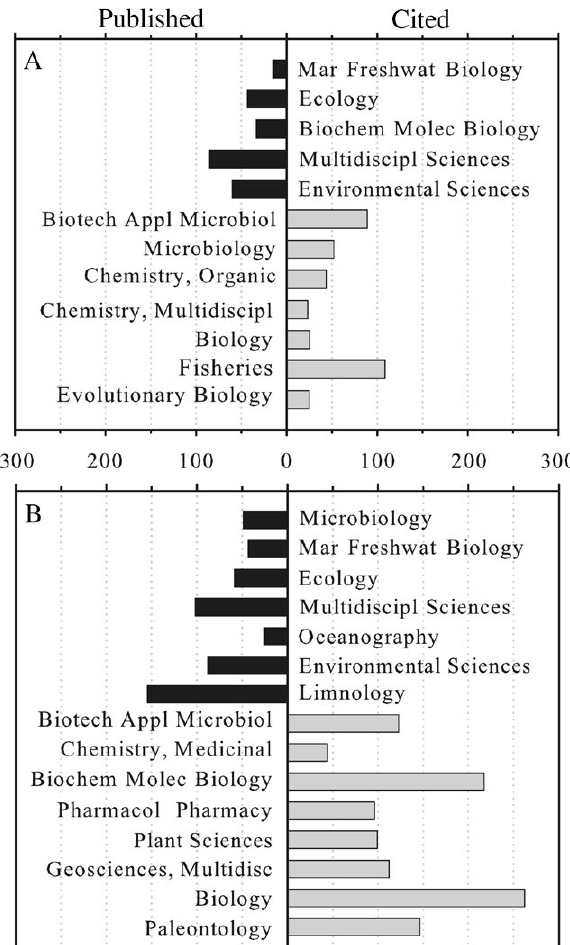
Fig. 2. – Increasing rate (%) of papers on chemical (A) and micro- bial (B) ecology published ([published − cited] / cited; in black) or cited ([cited − published] / published; in grey) within several subject categories found in the Science Citation Index Expanded database. Subject categories were ordered within published or cited papers as a function of the percentage of the total papers represented by each category in descending order. The remaining categories were excluded either because the proportions of papers published or cited were equivalent (i.e. the relative value did not deviate from 1) or because the percentage of the total papers in a subject category was below 1%. Black bars show a higher proportion of chemical and microbial ecology papers published than cited, whereas the opposite is true for grey bars. Mar Freshwat Biology, Marine and Fresh- water Biology ; Biochem Molec Biology, Biochemistry and Mo- lecular Biology ; Multidiscipl Sciences, Multidisciplinary Sciences ; Biotech Appl Microbiol, Biotechnology and Applied Microbiology ; Chemistry, Multidiscipl, Chemistry, Multidisciplinary ; Pharmacol Pharmacy, Pharmacology and Pharmacy ; Geosciences, Multidisc, Geosciences, Multidisciplinary